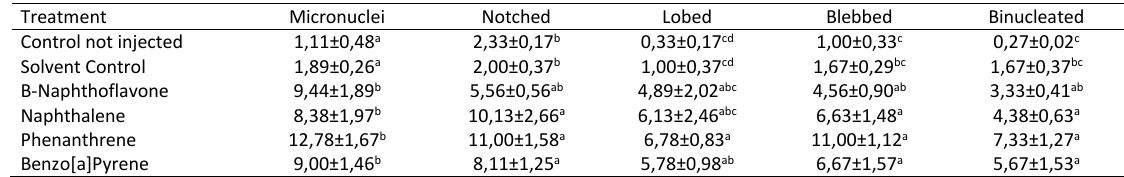
Table 3: Frequency of micronuclei and other nuclear abnormalities in peripheral blood of juvenile A. metae exposed to different concentrations Table 2: Degree of tissue change (DTC), average diameter, area and number of the hepatocytes nuclei in the liver tissue of juvenile A. of PAH after 72 h metae exposed to different concentrations of PAH after 72 hours Treatment